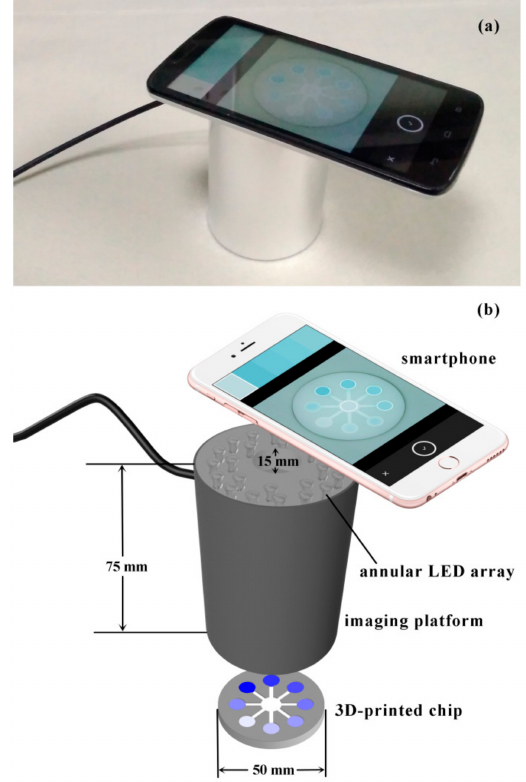
Figure 2. The image ( a ) and schematic diagram ( b ) of the developed system. In order to show the annular LED array, the opaque top surface of the imaging platform is drawn transparent in ( b